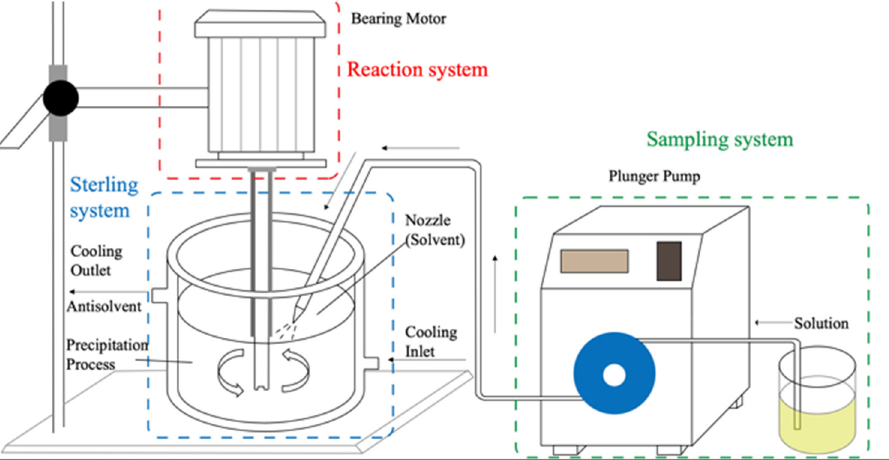
Figure 1. Antisolvent recrystallization under low-speed homogenate process (includes sampling system, reaction system and sterling system). Reprinted from ref. [22].